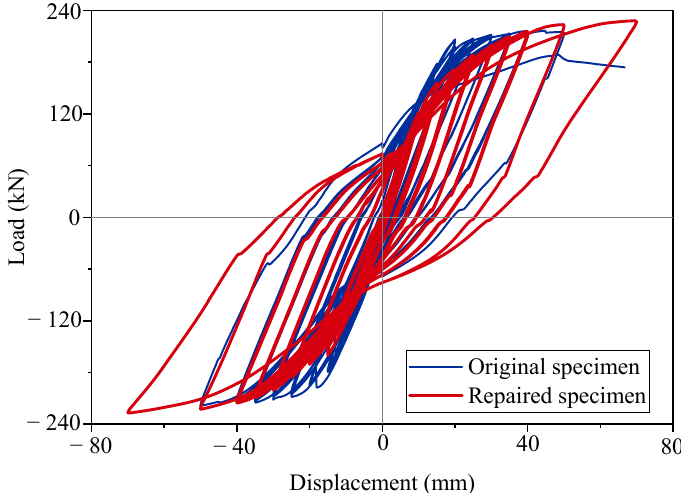
Figure 10. Load–displacement curves.